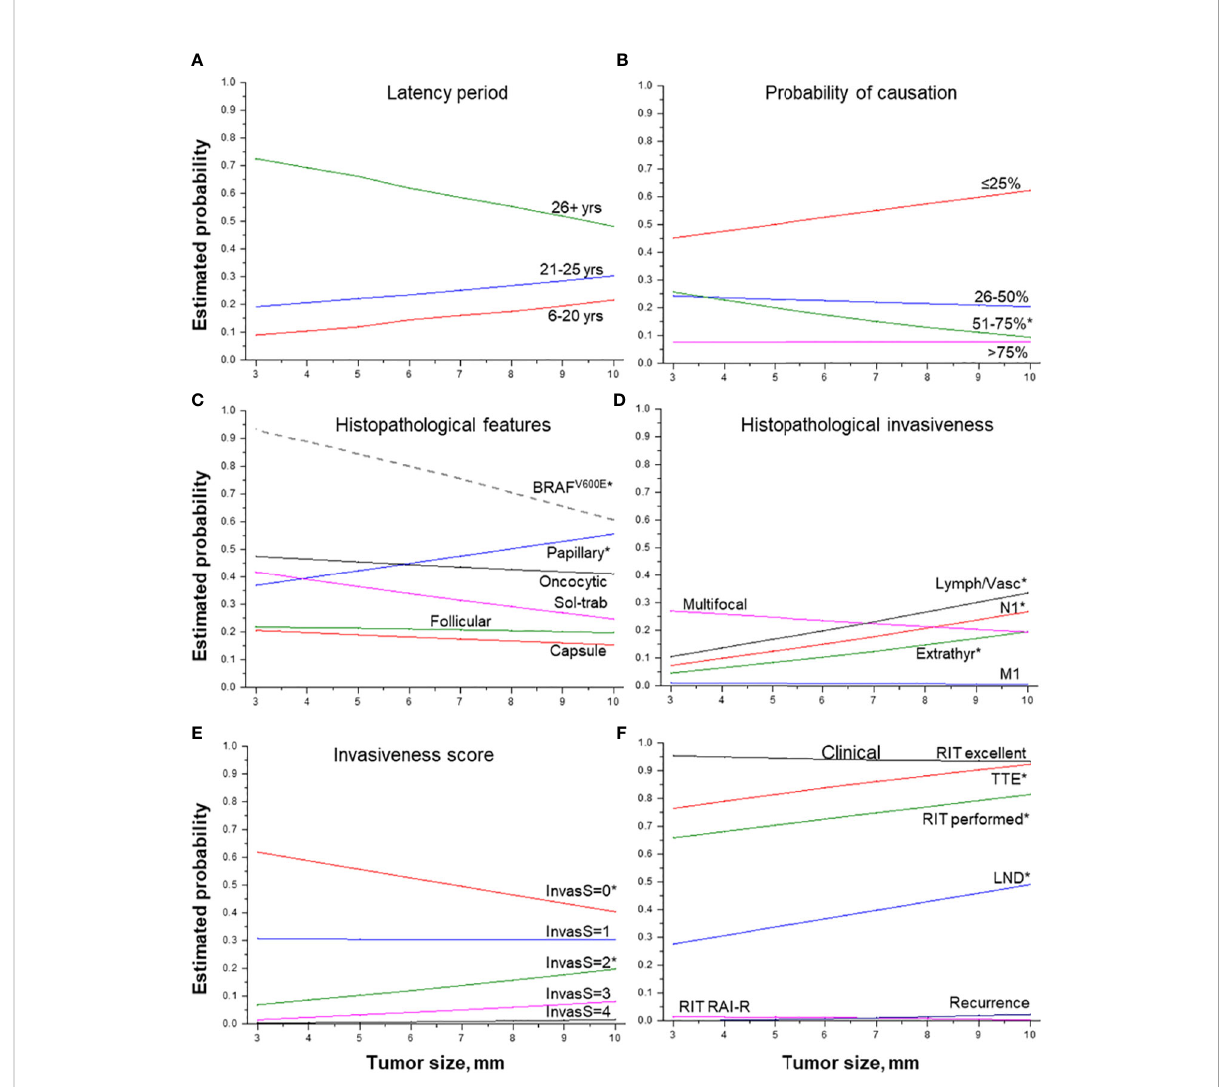
FIGURE 4 Effect of tumor size on MPTC characteristics. (A) latency period (by groups), (B) probability of causation (by 25%), (C) histopathological features, (D) histopathological features of tumor invasiveness, (E) the integrative invasiveness score, and (F) clinical parameters. RIT, radioiodine therapy; TTE, total thyroidectomy; LND, lymph node dissection; RAI-R, radioiodine-refractory. * indicate statistical signi fi cance, p <